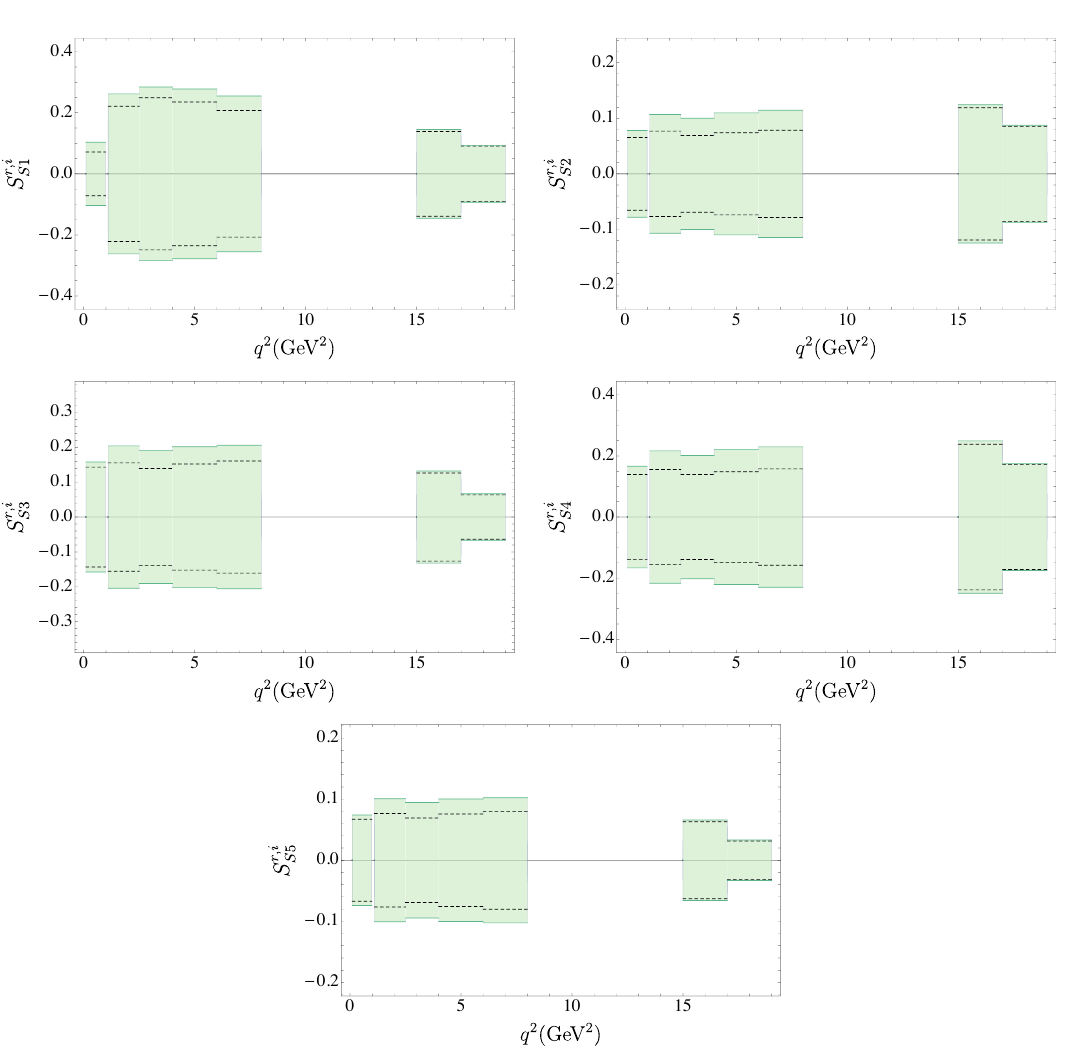
Figure 3 . Bounds for S r,i binned observables with i = 1 , 2 , 3 , 4 , 5 . The dashed line corresponds Si to the central value of the bound in the SM, while the green regions include the uncertainty of the observables that define the bound in the SM.